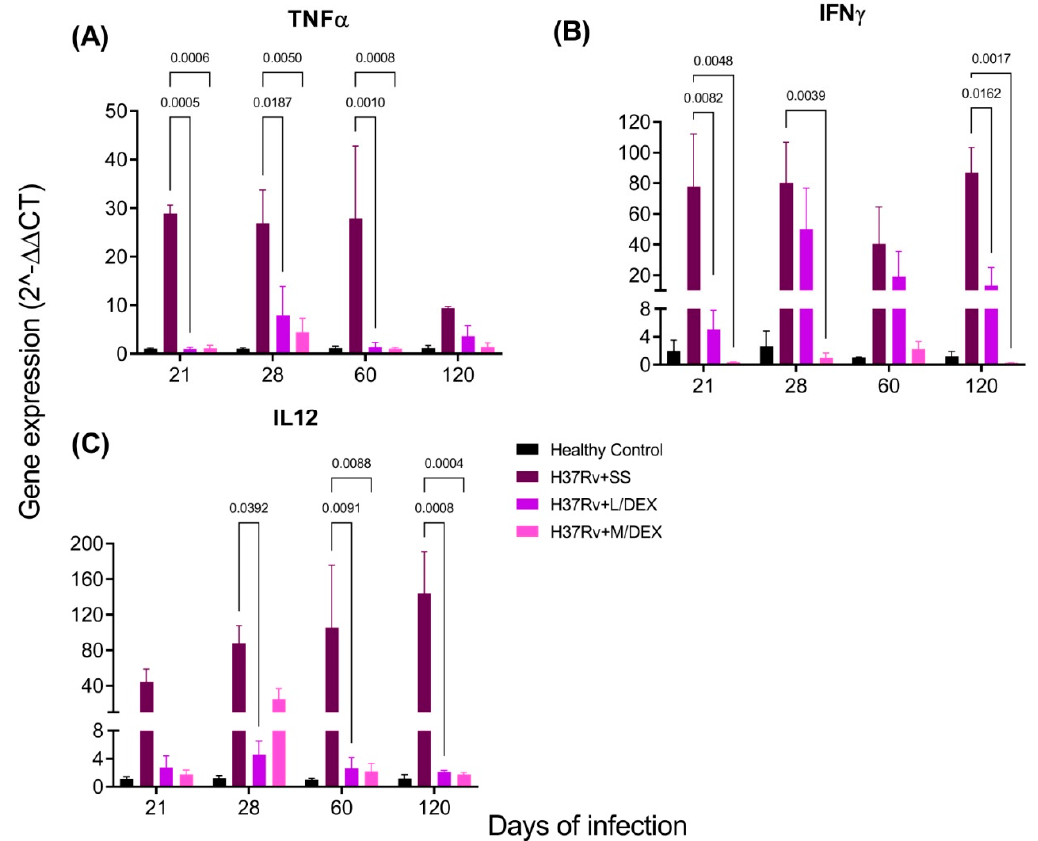
Figure 9. Effect of IN L/DEX (0.05 mg/kg BW) and M/DEX (0.25 mg/kg BW) on pro-inflammatory cytokines of the frontal cortex of mice infected with Mtb H37Rv. ( A ) TNF α . F (3, 30) = 20.56, p < 0.0001. REML. Dunnett’s multiple comparisons test. ( B ) IFN γ . F (3, 8) = 15.47, p = 0.0011. REML. Dunnett’s multiple comparisons test. ( C ) IL-12. F (3, 8) = 6.149, p = 0.0179. REML. Dunnett’s multiple comparisons test. There is a significant increase in gene expression in the absence of any detectable brain infection since day 21 post-infection. The treatment with M/DEX dose reduced the expression of these pro-inflammatory cytokines. RNA was isolated from frontal cortex homogenates, reverse-transcribed to cDNA and then analyzed for gene expression changes of the indicated cytokine. Fold-change values were normalized to expression levels of the healthy controls ( n = 6).